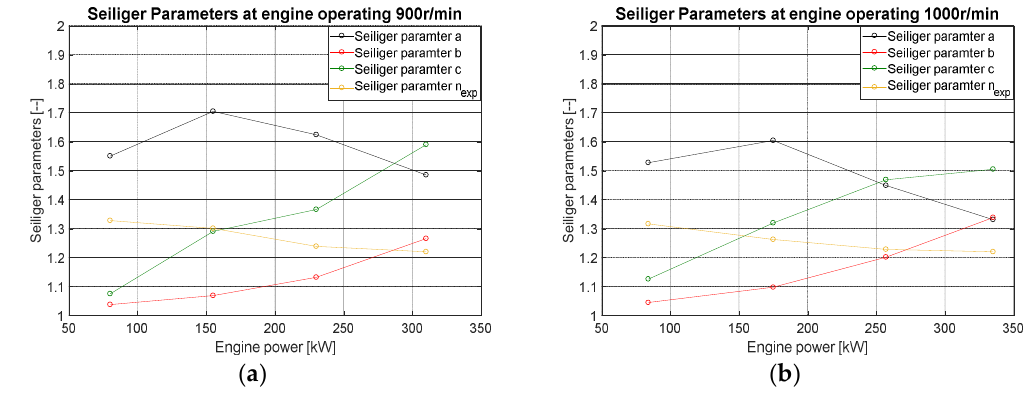
Figure 11. Seiliger parameters at engine constant speed: ( a ) 900 r/min; ( b ) 1000 r/min.